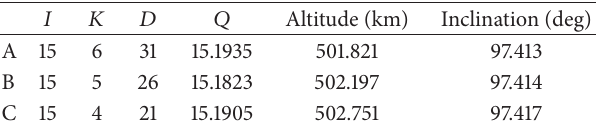
Table 1: Parameters of some repeating sun-synchronous orbits when the altitude range is 501–503